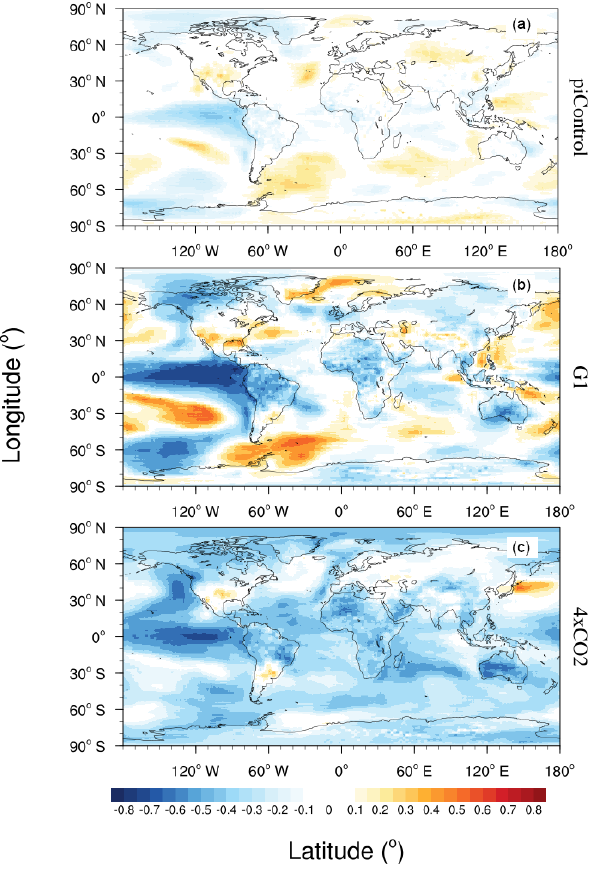
Figure 12. Mean correlation between yearly STRF and global grid- ded 2m temperatures for 100 years of piControl (a) and the final 30 years of G1 (b) and abrupt4xCO2 (c) experiments for the eight- model ensemble